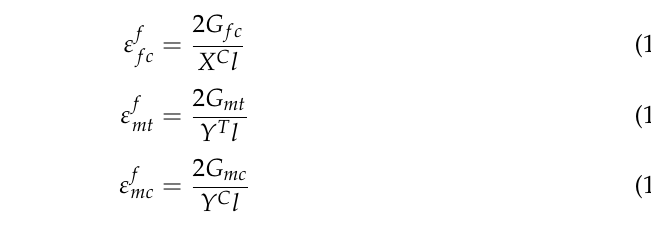
Figure 3 . Force-time relations under 47.6 J of impact energy. Table 3 . Comparison of numerical and experimental results. Sample